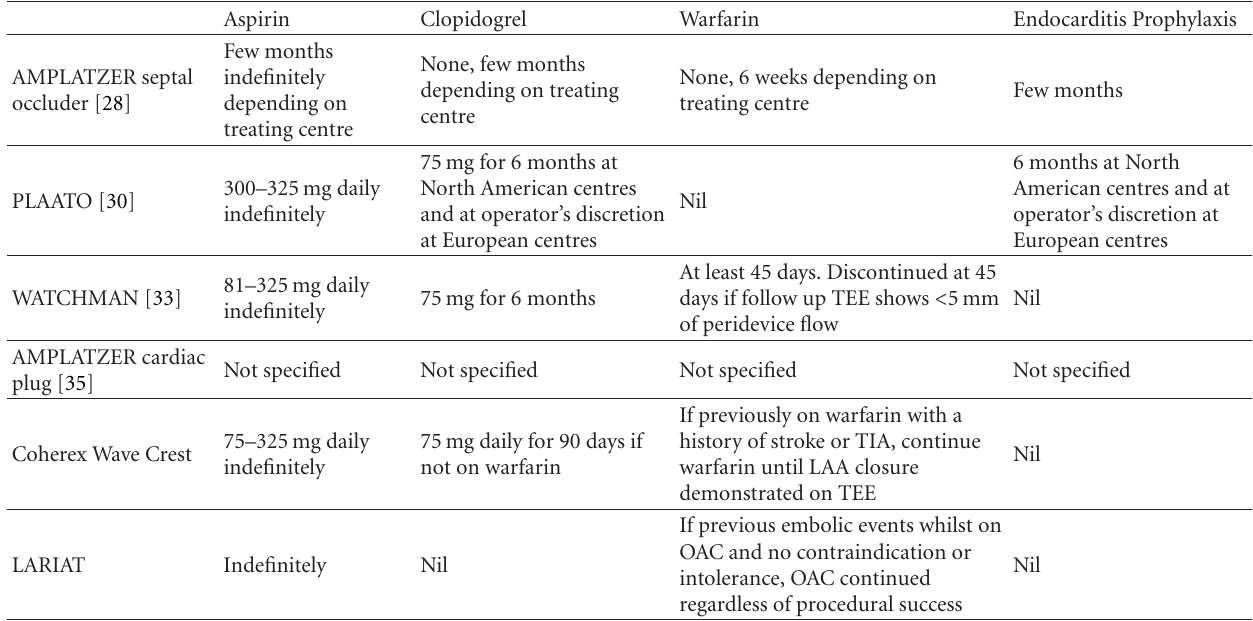
Table 2: Summary of antiplatelet/anticoagulation requirements and endocarditis prophylaxis for each percutaneous